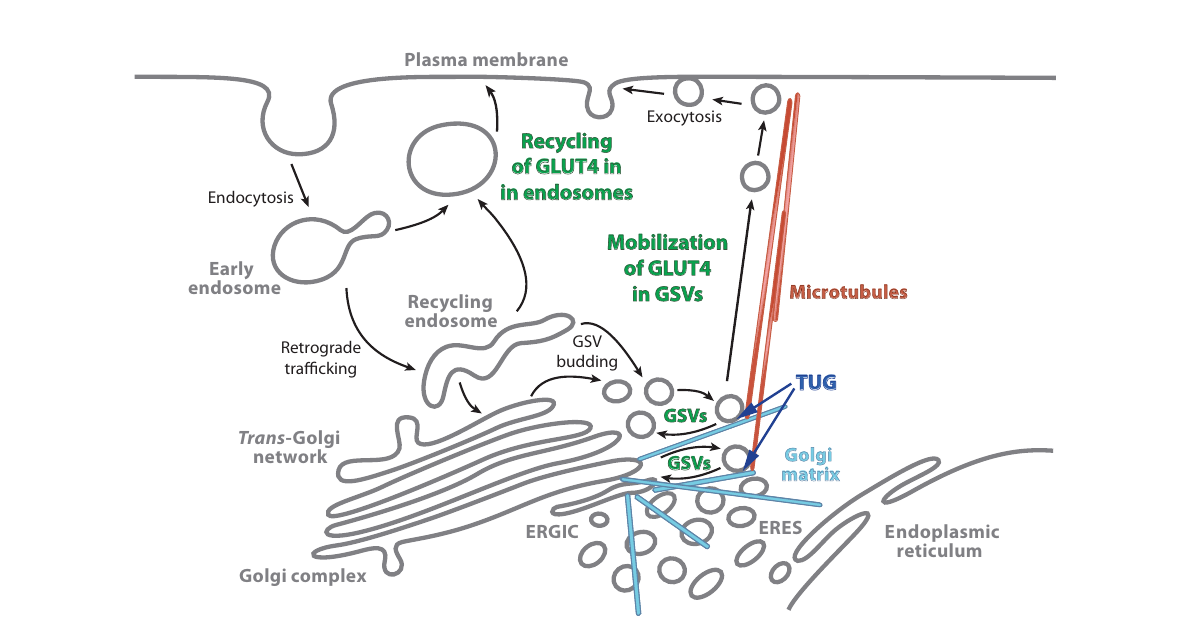
FIGURE 2 Actions by which insulin stimulation causes increased plasma membrane GLUT4. Insulin stimulates the mobilization of GLUT4 Storage Vesicles (GSVs), and also redirects endocytosed GLUT4 so that it returns directly to the plasma membrane from endosomes. In unstimulated cells, most GLUT4 accumulates in GSVs. These vesicles are trapped at the Golgi matrix by the action of intact TUG with other proteins, and they may participate in a cycle involving internal membranes (as described in the text). Insulin stimulates the acute proteolytic processing of TUG to mobilize the GSVs on microtubule motors directed toward the cell surface. The GSVs fuse at the plasma membrane, and the liberated GLUT4 is then able to populate the endosomal system. During ongoing insulin exposure, recycling of GLUT4 in endosomes becomes a signi fi cant source of GLUT4 arriving at the plasma membrane. The model that is depicted is based primarily on studies in adipocytes; data suggest that it holds in muscle as well. In skeletal muscle, data from TUG knockout mice imply that other sites at which insulin modulates GLUT4 traf fi cking are less important for its overall distribution at the cell surface. ERGIC, Endoplasmic Reticulum – Golgi Intermediate Compartment; ERES, Endoplasmic Reticulum Exit Sites. The fi gure is modi fi ed from Bogan JS,